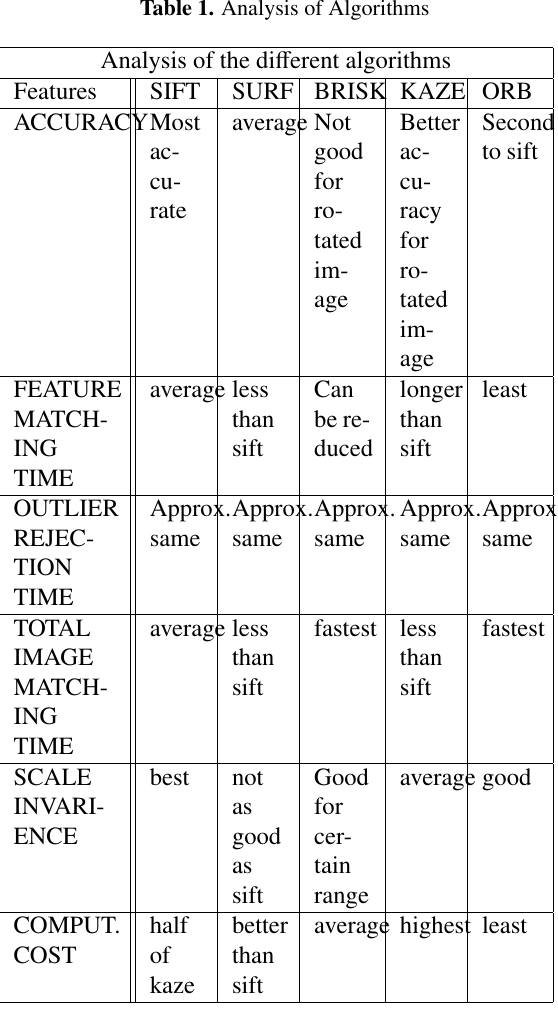
Table 1. Analysis of Algorithms